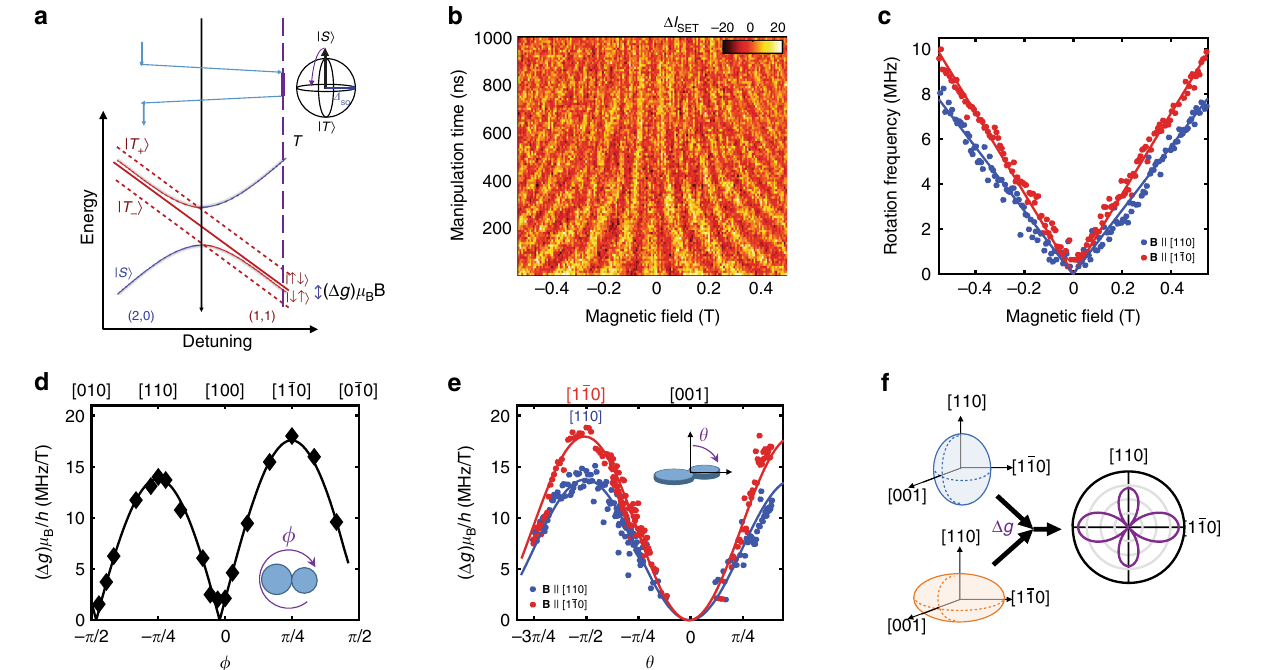
Fig. 2 MOS interface spin – orbit interaction. a Energy diagram and gate pulse schematic for controlling spin – orbit rotations. We initialize the qubit into the S (2, 0) ground state and transfer the system to the (1, 1) charge sector with a rapid adiabatic pulse, such that it remains a singlet. The difference in Zeeman splitting between the QDs drives X -rotations between the S (1, 1) and T 0 (1, 1) states. A rapid adiabatic return pulse projects the states onto the S (2, 0) and T 0 (1, 1) basis for measurement. b Change in charge sensor current as a function of X -rotation manipulation time as the magnetic fi eld is varied along the ½ 110 (cid:2) crystallographic direction. c The extracted rotation frequency as a function of magnetic fi eld strength along the [110] and ½ 110 (cid:2) crystallographic directions. d , e Magnetic fi eld angular dependence of the SO-driven difference in g -factor between the dots for the in-plane, θ , and out-of-plane, ϕ , directions, respectively. Fits to the form ð Δ g Þ μ B = h = B j j Δ α (cid:3) Δ β sin ð 2 ϕ Þj j sin 2 ( θ ) are also plotted for θ = π /2 (black), ϕ = 3 π /4 (blue) and ϕ = π /4 (red). f B A cartoon representation of the angular dependence of the two QDs (left). The difference between the QD g -factors give an in-plane dependence represented by the cloverleaf plot on the